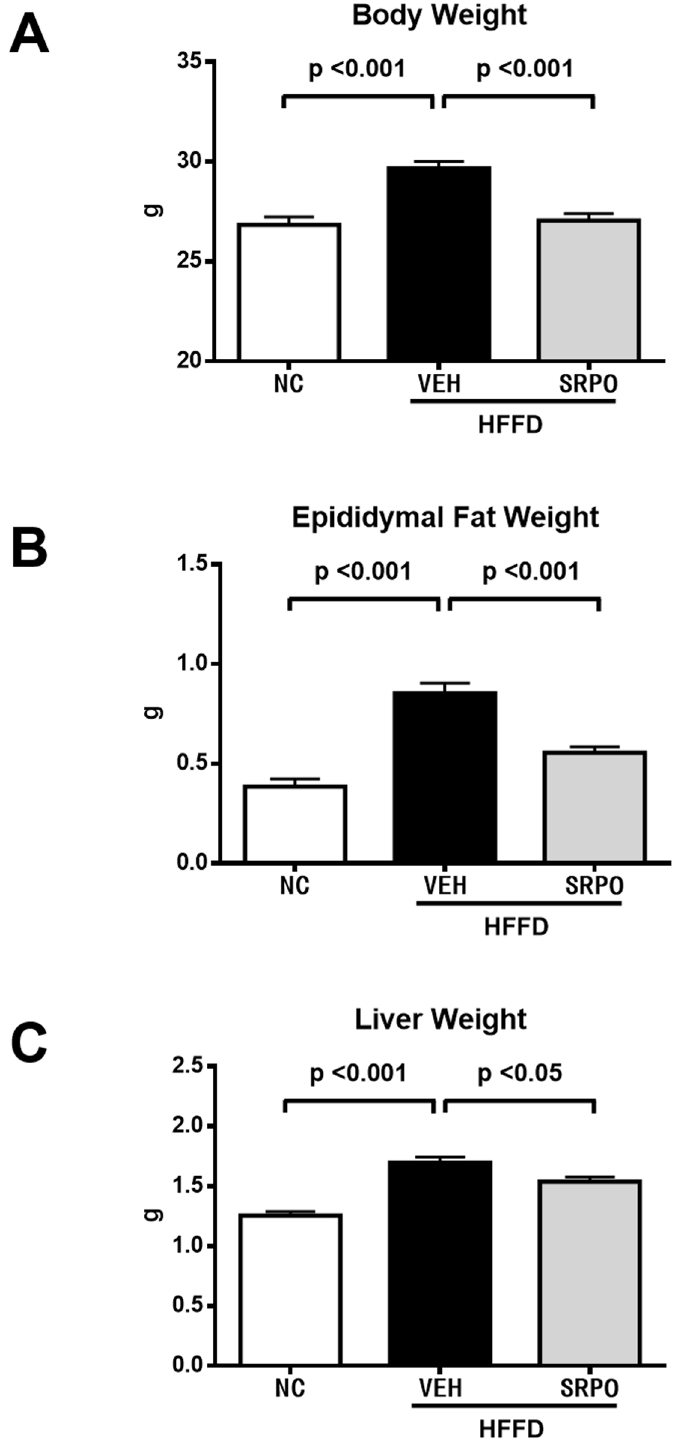
Fig 1. Effects of SRPO on HFFD-induced obesity. (A) Body weight (n = 17, 28, 29). (B) Epididymal fat weight (n = 13, 18, 18). (C) Liver weight (n = 17, 23, 25). Values are the mean ± SE in each group. (Abbreviations: NC = normal chow; HFFD = high-fat high-fructose diet; VEH = vehicle; SRPO = Sarpogrelate hydrochloride.)